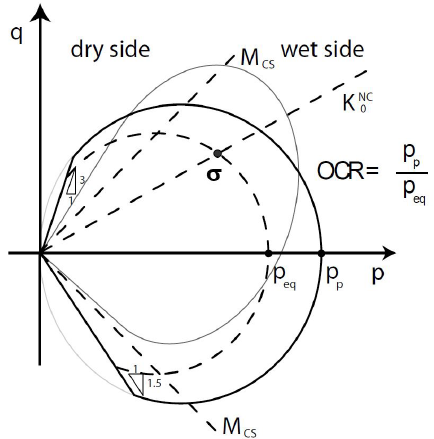
Figure 11: MCC model – the real yield surface known from high accuracy experiments, for example, [38, 43], is indicated with grey colour. M is the slope of the CSL [24]. CS